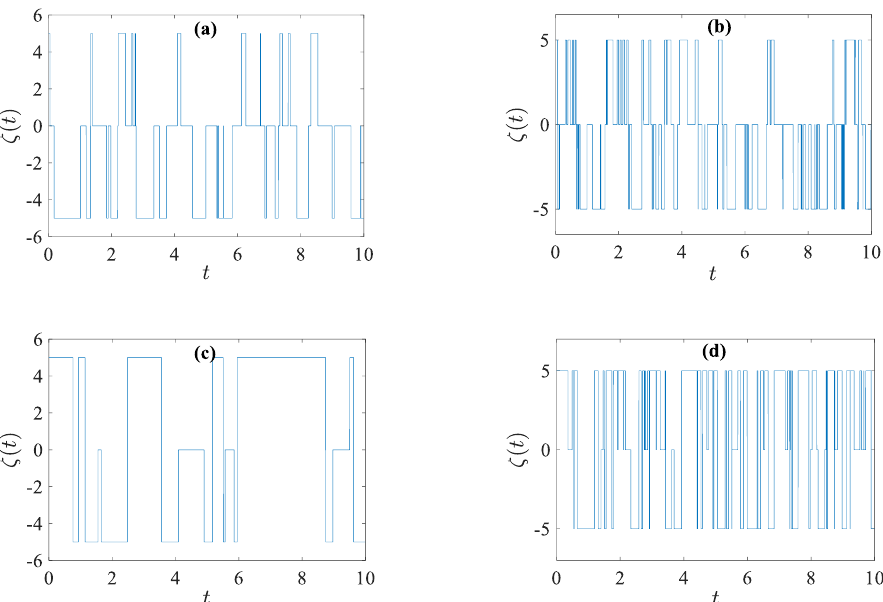
Figure 13. Generation of trichotomous colored noise for ( a ) τ cor = 0.3, p = 1/4, ( b ) τ cor = 0.06, p = 1/4, ( c ) τ cor = 0.3, p = 2/5, ( d ) τ cor = 0.06, p = 2/5.